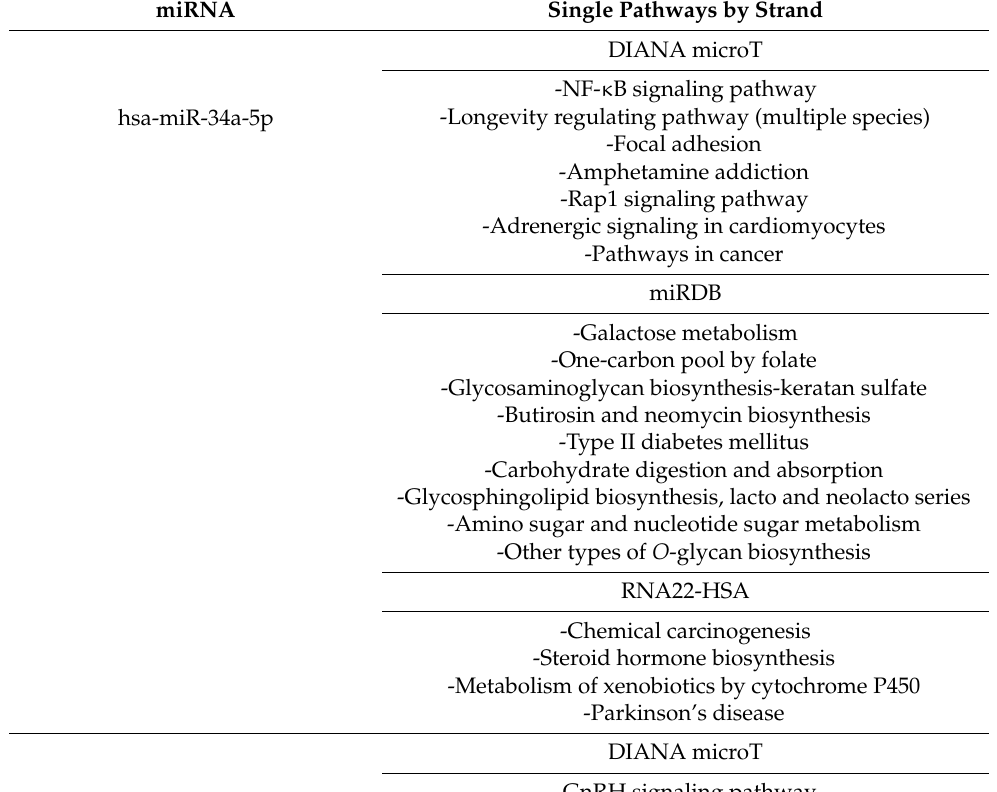
Table 2. Cell pathways regulated exclusively by 5 and 3p strands of miR-34 family